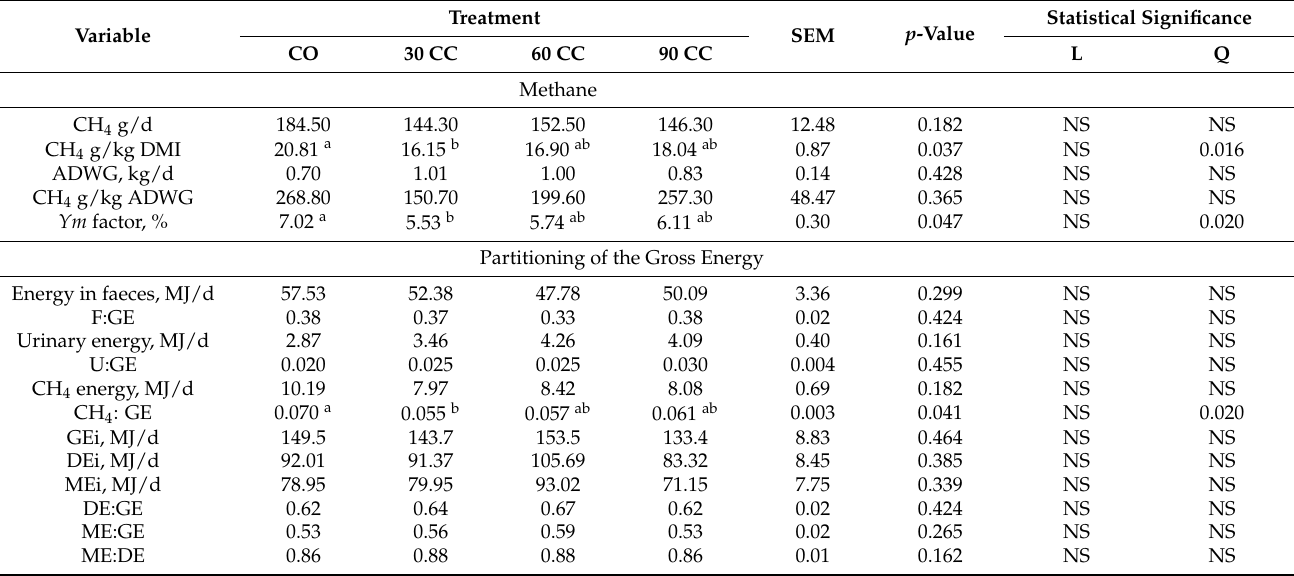
Table 3. Methane emission and partitioning of the gross energy intake for heifers supplemented with different levels of Cymbopogon citratus supplementation.